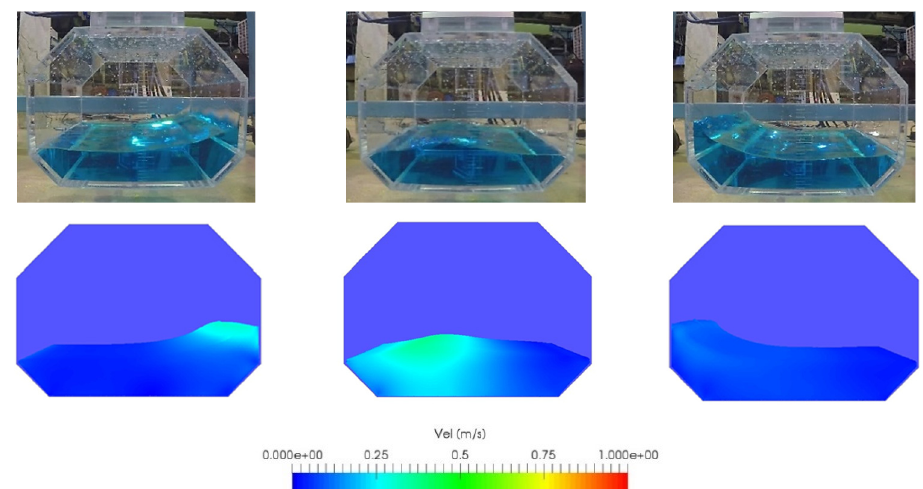
Figure 7. Free surface evolution under sway oscillations at t = 9.8 seconds, 10.0 seconds, and 10.2 seconds with a 25% filling ratio.